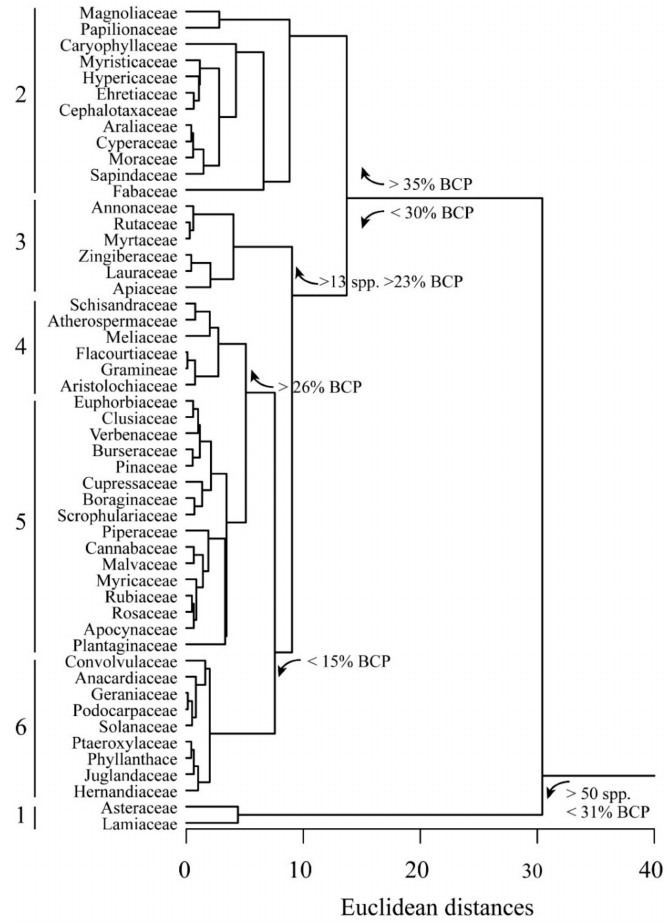
Figure 3. Cluster analysis of BCP and yield percentages according to the plant families. Euclidean distances are calculated with average linkage method. Six clusters are evident (see text for